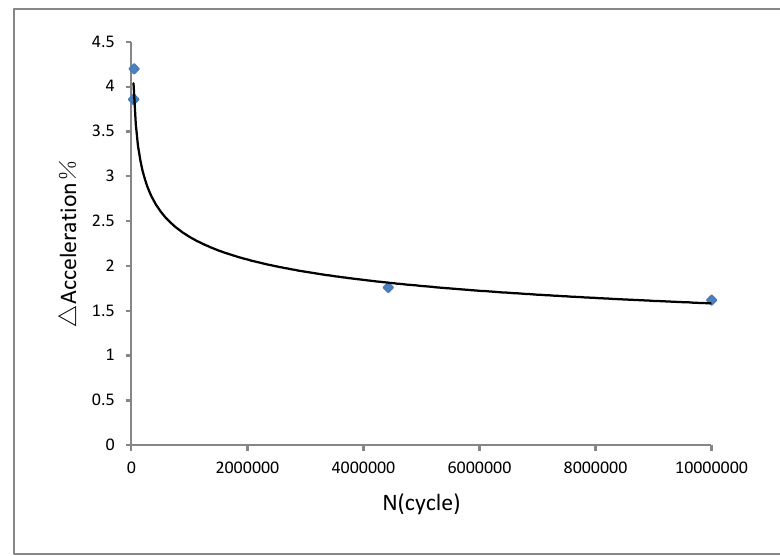
Figure 9. Acceleration reduction for vibration fatigue experimental end criteria.